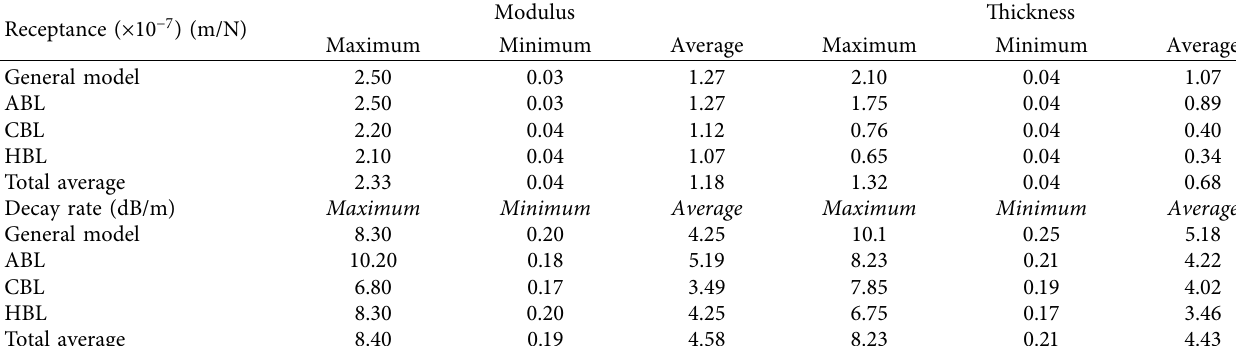
Table 4: The effect of modulus and thickness on receptance and decay rate in layers.